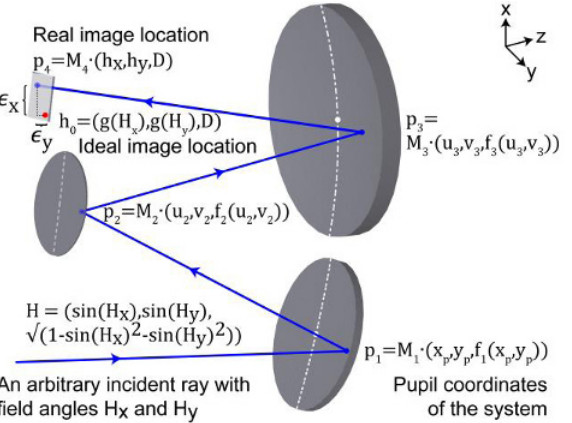
Fig. 1. Schematic layout of a typical plane-symmetric freeform optical system. The ray path of an arbitrary ray is shown including the introduced mathematical description of the initial ray direction and intersections with each mirror and the local transverse ray aberrations ϵ x and ϵ y in the image plane.